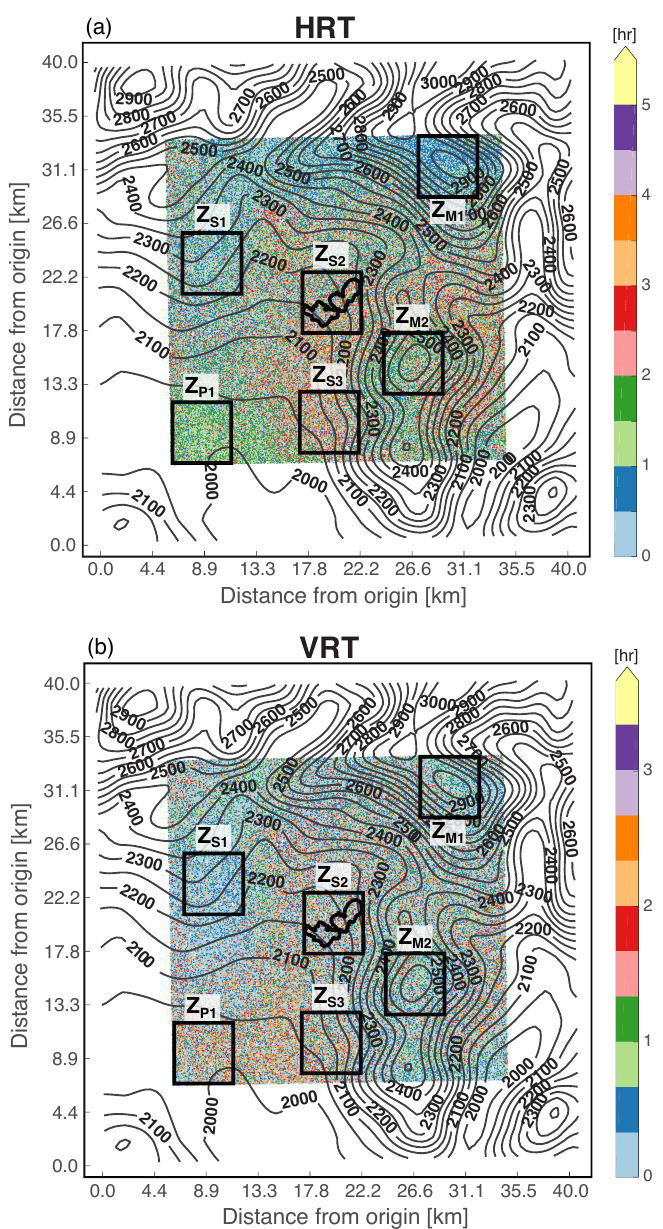
Figure 7. Initial particle positions within release zone, with marker color indicating ( a ) horizontal residence time (RT) (HRT) (h) within a 5-km-radius circle centered on the particle release point and ( b ) vertical RT (VRT) (h) within a 250-m-deep layer above the particle release level. Contours of surface elevation (dark gray lines; interval: 50 m) are overlaid on the particles, the black polygons in the center of each panel depict the perimeters of the two burn units active on 10 September 2018, and the six analysis zones discussed in the text are indicated with black squares: Z M1 , Z M2 , Z S1 , Z S2 , Z S3 , and Z P1 (see text for naming